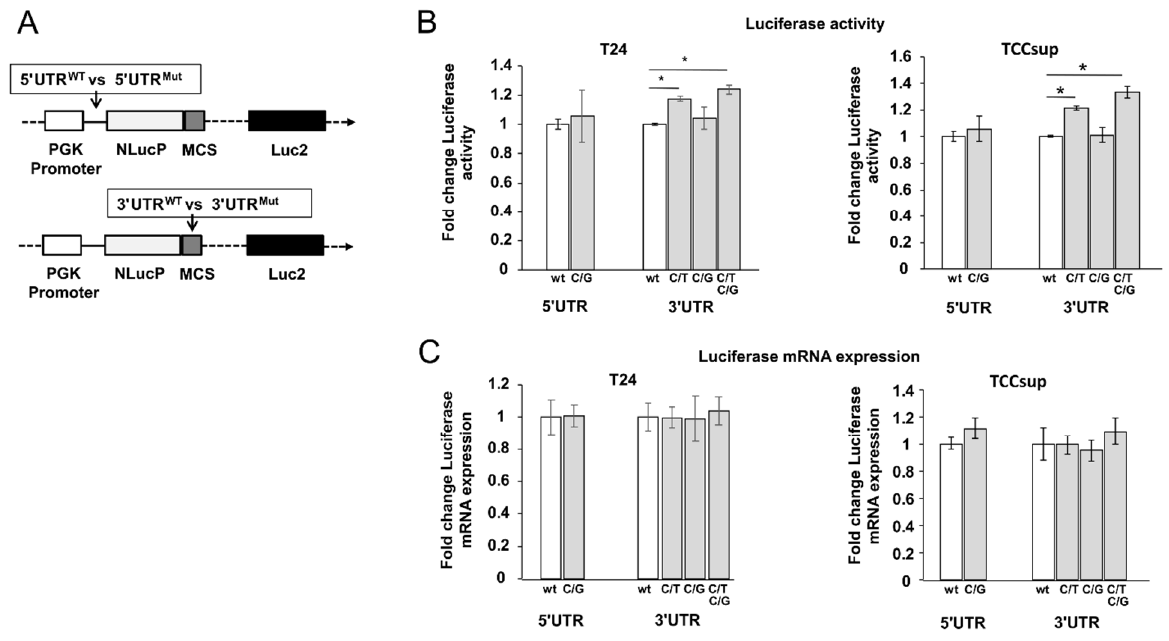
Figure 3. Untranslated region (UTR)-mutation analysis of SLC35F2 by luciferase reporter assay. ( A ) Schematic view of the whole UTR sequencing cloned in luciferase reporter. The wildtype and mutated 5 ′ UTR sequences were cloned upstream, while the wildtype and mutated 3 ′ UTR were cloned downstream of the NLucP reporter. The bladder cancer cell lines T24 ( n = 4) and TCCsup ( n = 4) were transfected with the luciferase plasmids and after 24 h luciferase activity ( B ) and mRNA ( C ) were analysed. The Luc2 luciferase was used for normalisation to eliminate variations from transfection. The data are expressed as mean ± standard deviation and statistical analysis was performed by non-parametric Mann–Whitney U-test with * p -value < 0.05. Values obtained from wild type sequences were set arbitrarily as 1. PGK: phosphoglycerate kinase, MCS: Multiple Cloning Site.